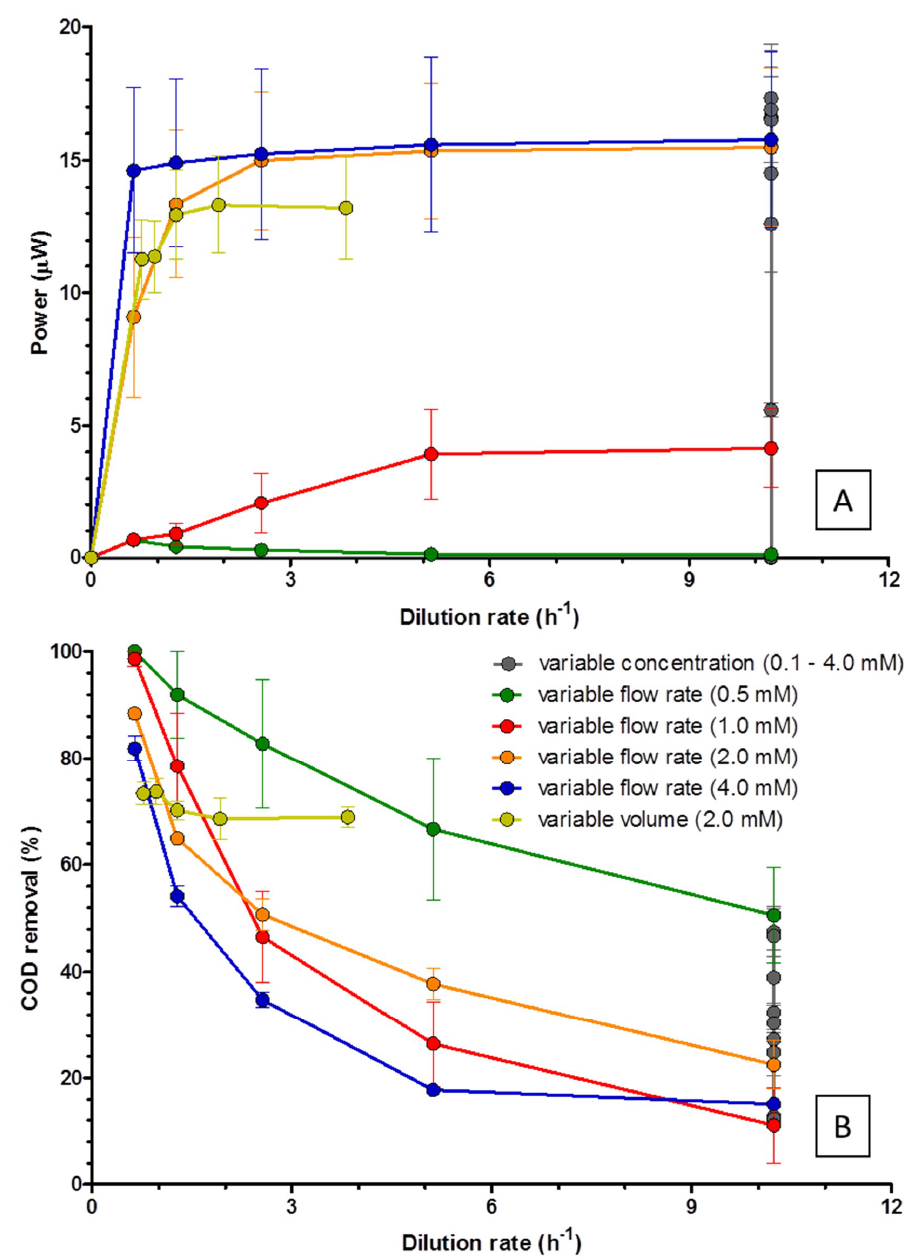
Figure 3. Power output ( A ) and COD removal efficiency ( B ), at different dilution Figure 3 . Power output ( A ) and COD removal efficiency ( B ), at different dilution rates.